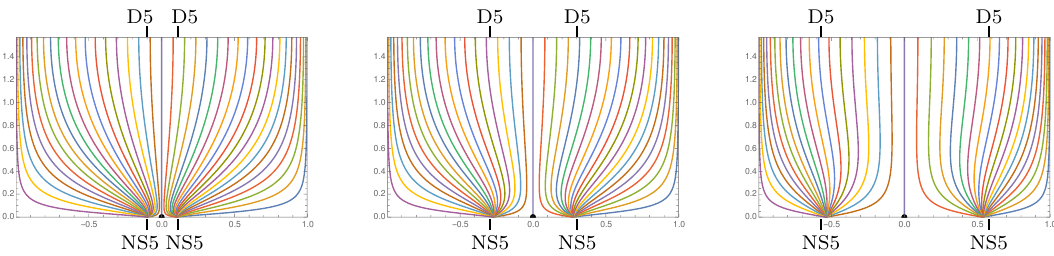
Figure 12. D5 0 Wilson loop embeddings for the D5 2 /NS5 2 theory on Σ , with tanh(Re( z )) on the horizontal axis and Im( z ) on the vertical axis, from left to right for δ ∈ { 0 . 1 , 0 . 28 , 0 . 6 } .